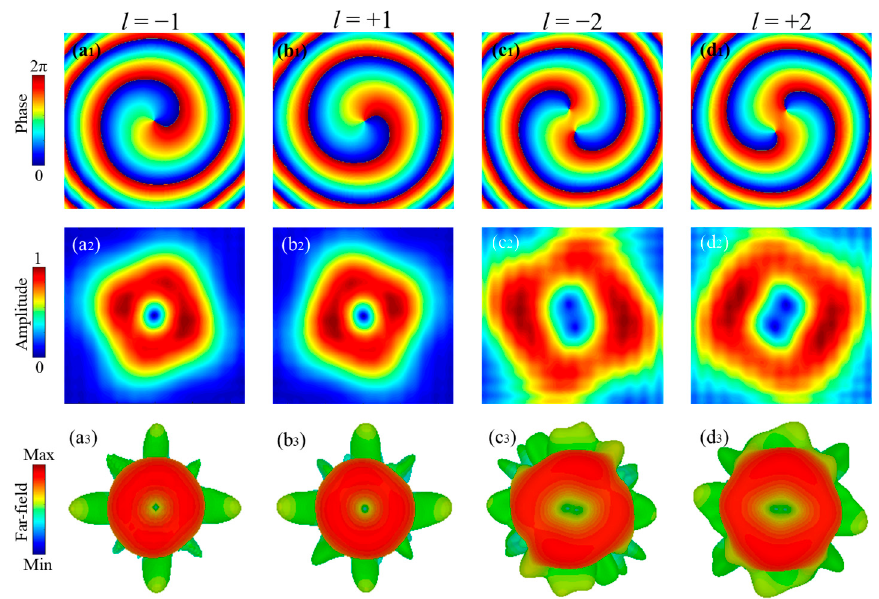
Figure 11. The phase, amplitude and far-field profile in x - y plane at 1 THz with ( a ) l = − 1, ( b ) l = +1, ( c ) l = − 2, ( d ) l = +2,